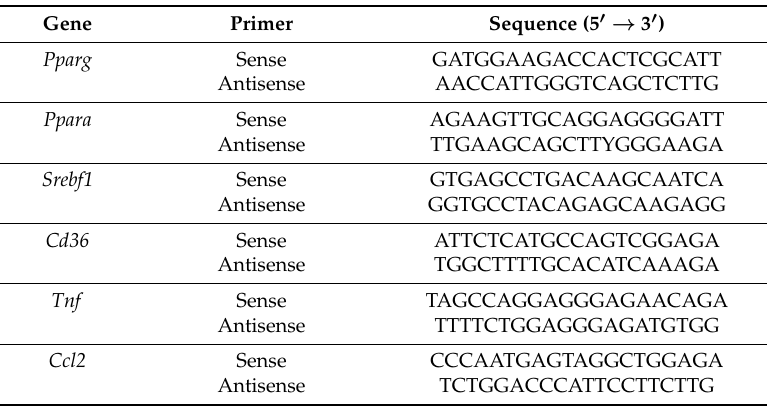
Table 4. Primers used for real-time